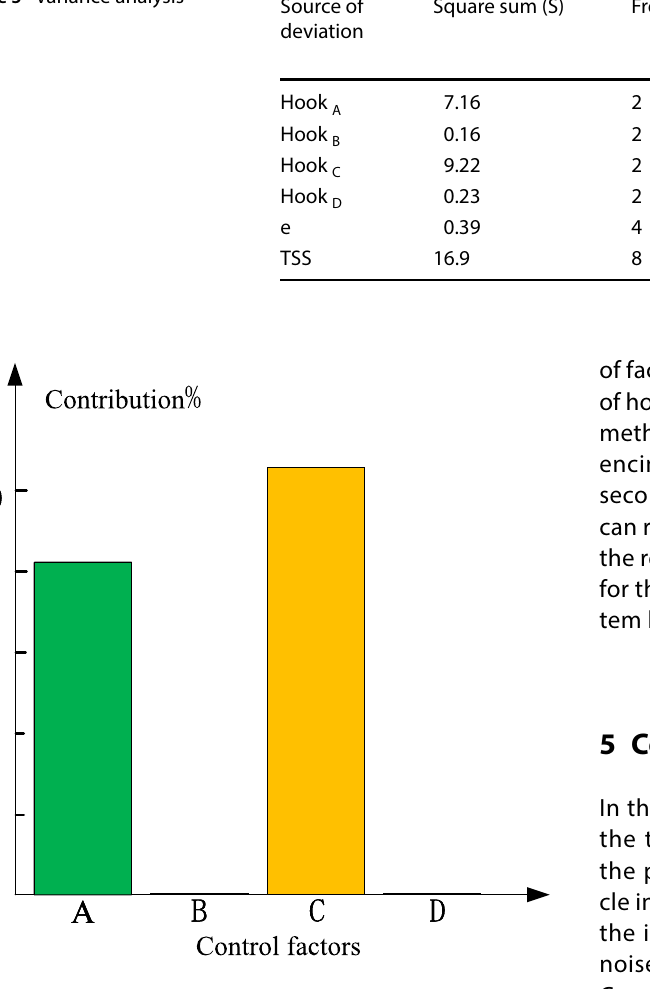
Table 3 Variance analysis